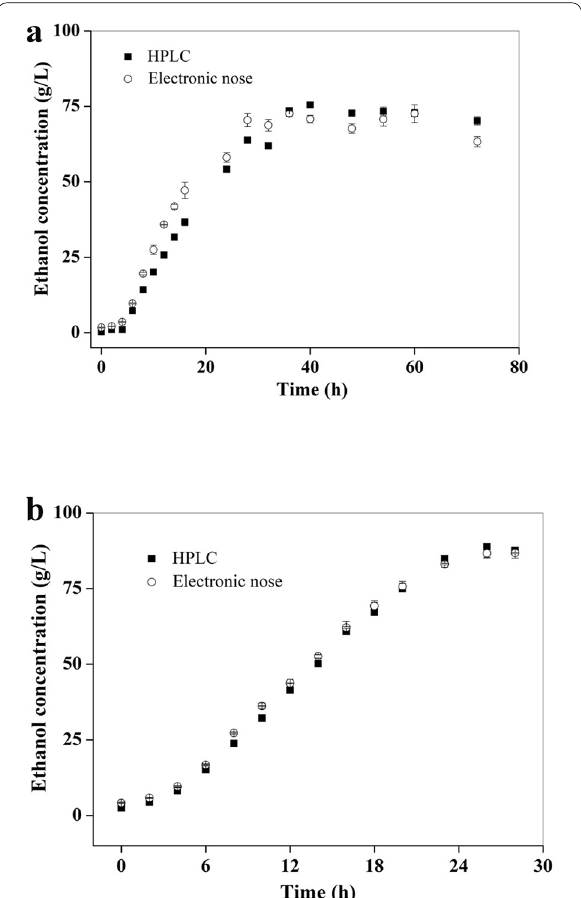
Fig. 5 Relationship between the ethanol concentrations determined by electronic nose and by HPLC. a Off-line determination of ethanol concentrations in shake-flask fermentation by electronic nose and by HPLC. b On-line determination of ethanol concentrations in a 5-L bioreactor fermentation by electronic nose and by